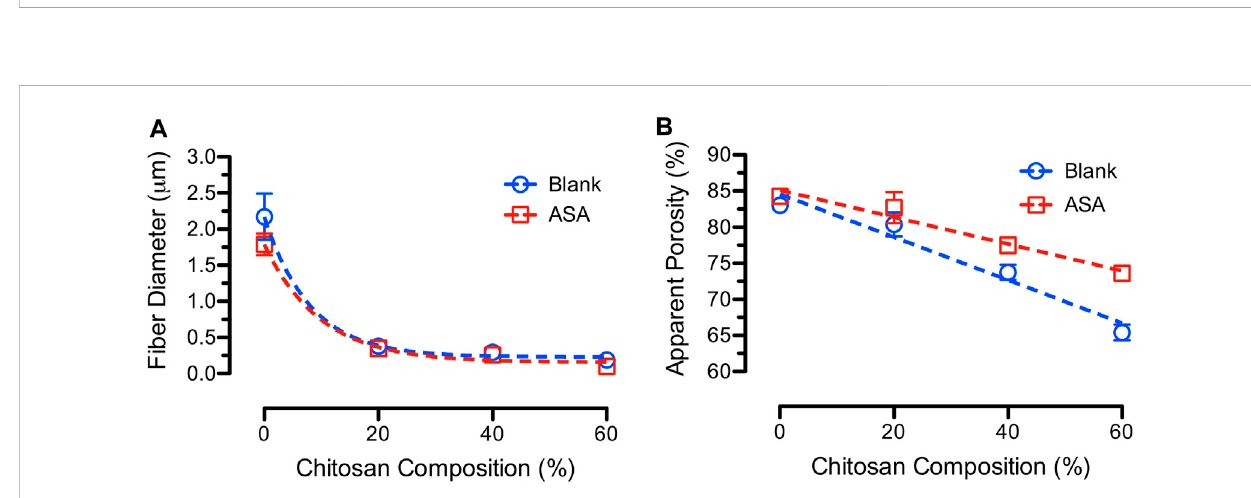
FIGURE 1 SEM imagesof electrospun PCL/CS blend fi bers at various compositions. The top row shows blank PCL/CS fi bers of (A) 100/0, (B) 80/20, (C) 60/40, and (D) 40/60compositions.ThebottomrowshowstheASA-loadedPCL/CS fi bersof (E) 100/0, (F) 80/20, (G) 60/40,and (H) 40/60compositions.Scale bar = 5